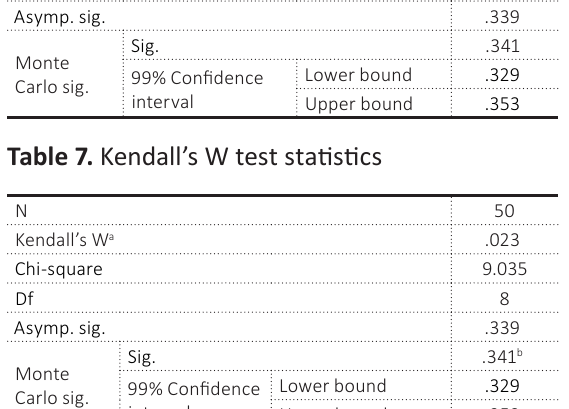
Table 5. Mean ranks for Friedman and Kendall’s